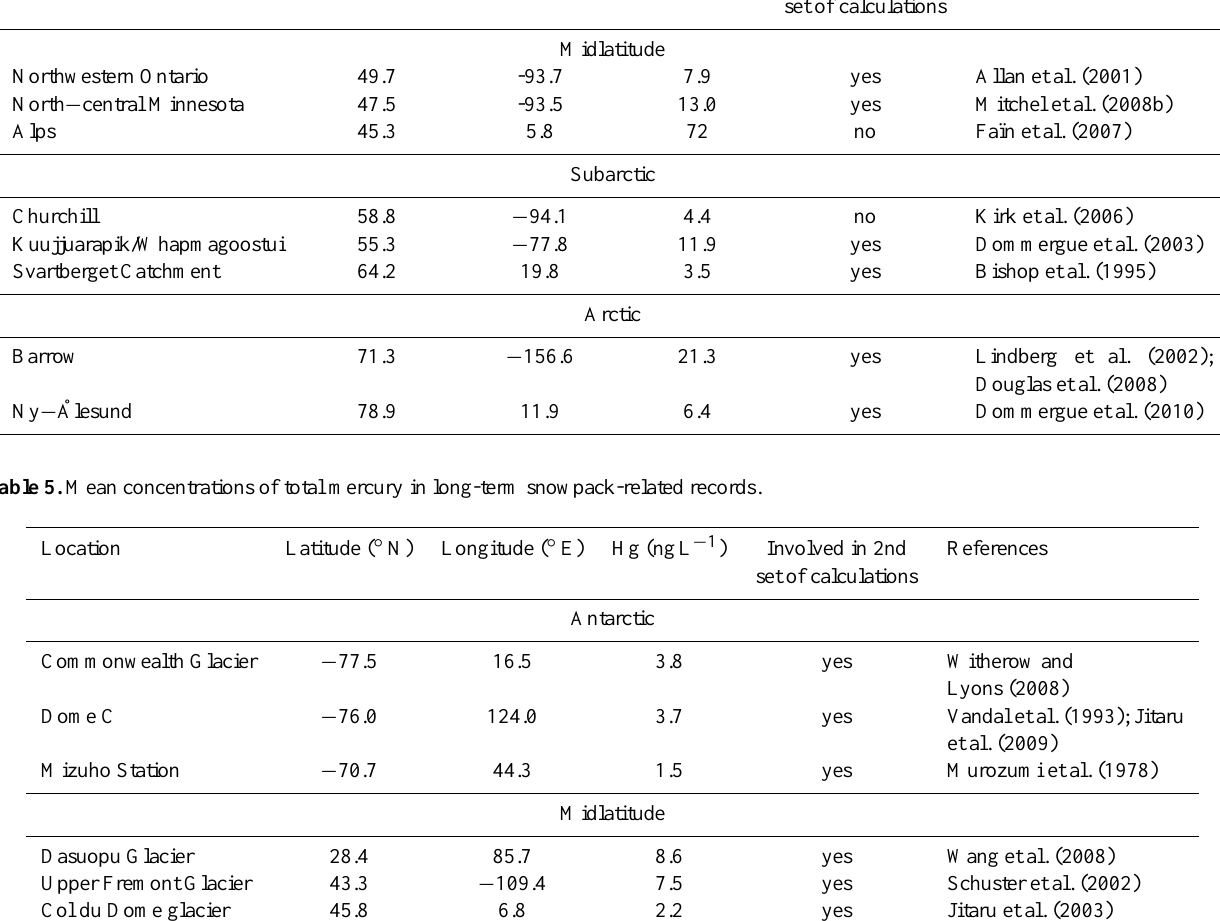
Table 4. Mean concentrations of total mercury in the snowpack meltwater’s ionic pulse. Location